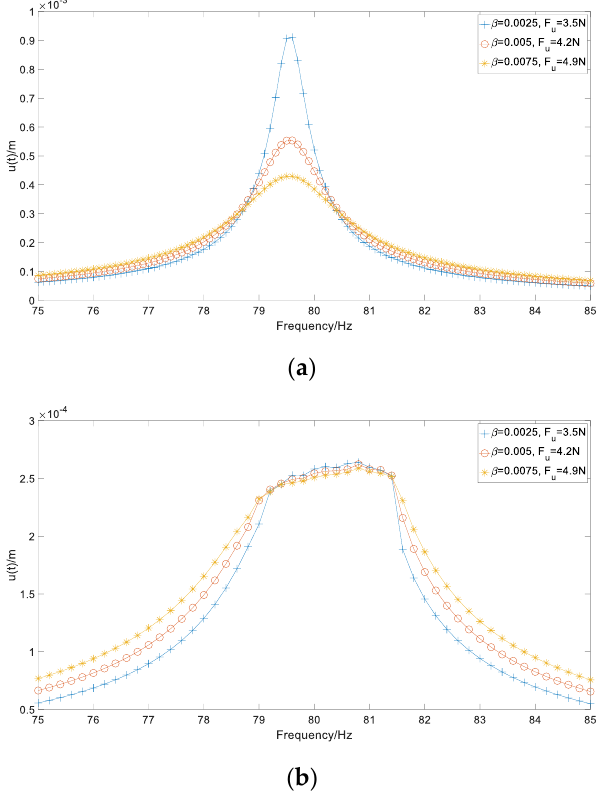
Figure 10. The forced responses of the system with different specific impedance ratio β under different excitation amplitude. ( a ) Without the membrane NES. ( b ) With the membrane NES.